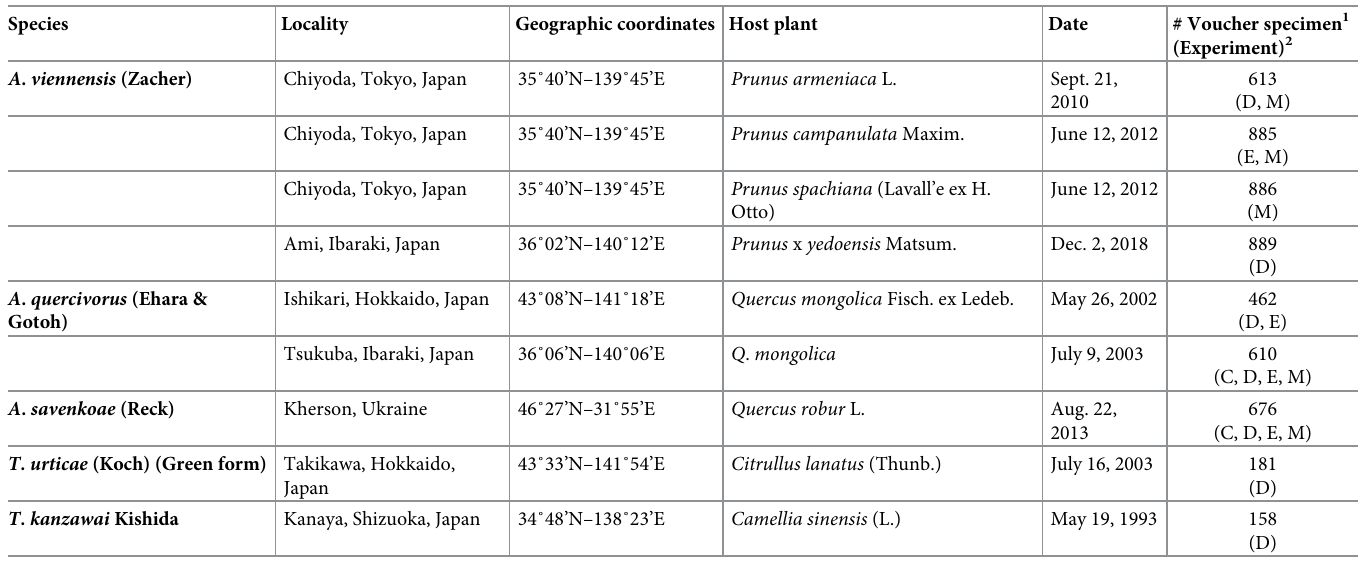
Table 1. Collection data for experiments conducted on nine strains of three Amphitetranychus and two Tetranychus species examined in the present study.